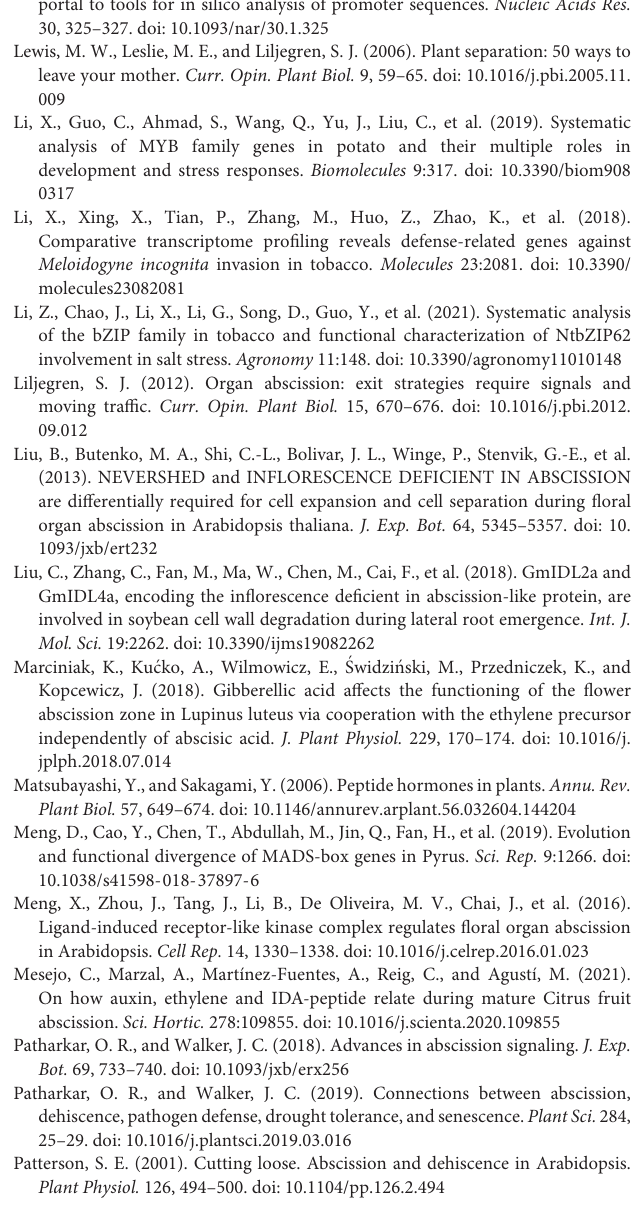
Supplementary Figure 1 | Sequence alignment of HAE-Like proteins from tobacco and Arabidopsis . The black background indicates that the amino acid